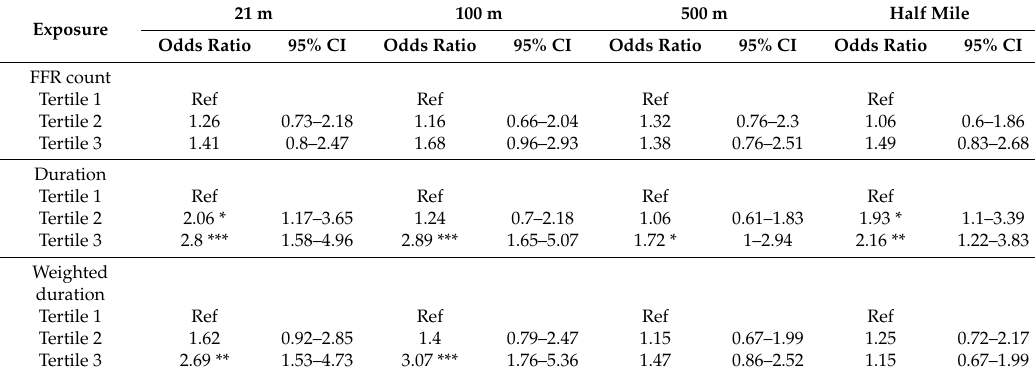
Table 4. Logistic regression using robust standard errors to predict FFR visitation.